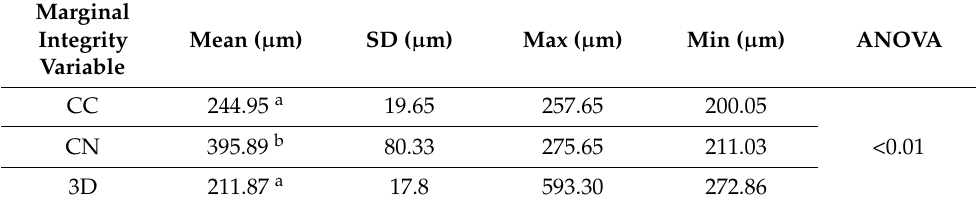
Table 2. Mean and SD for interim crown marginal Figure 3. Comparison of marginal integrity and adaptation for three fabrication techniques.